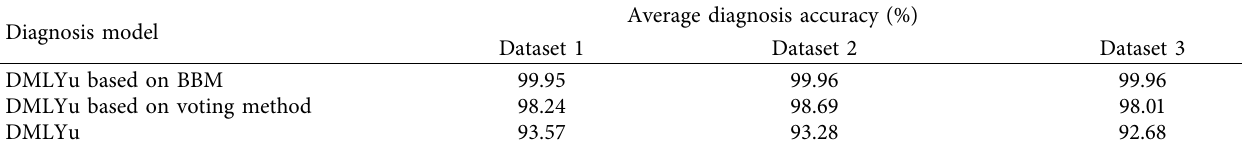
Table 2: Performance comparison between individual DMLYu and ensemble